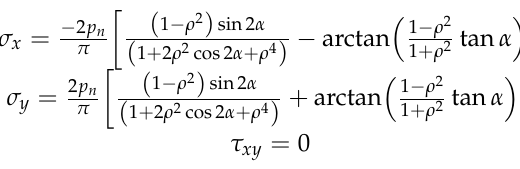
Figure 4. σ x contour map of the axial compression on the part boundary of the circular shaft.